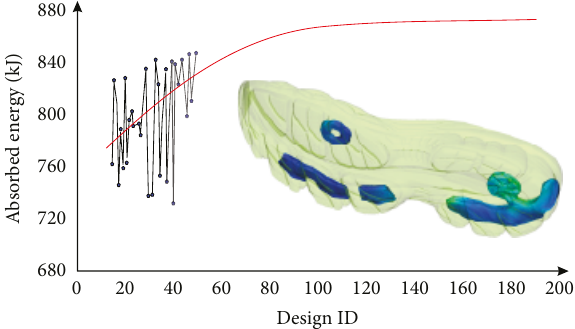
Figure 7: Convergence of optimization analysis towards the optimal